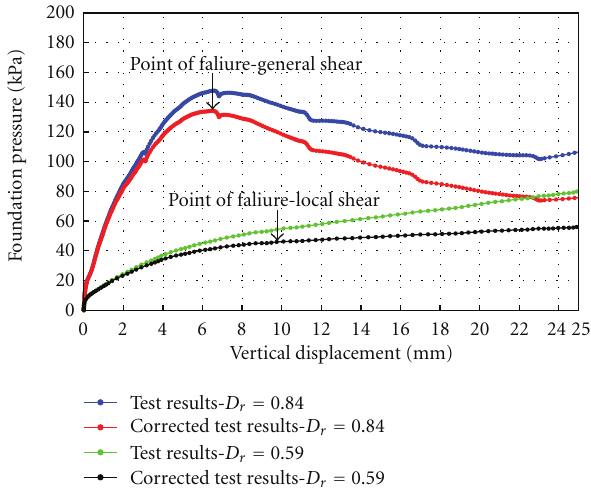
Figure 8: Definition of failure